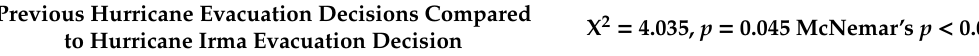
Table 4. Chi-square results between respondents’ previous hurricane evacuation decisions compared to their evacuation decision for Hurricane